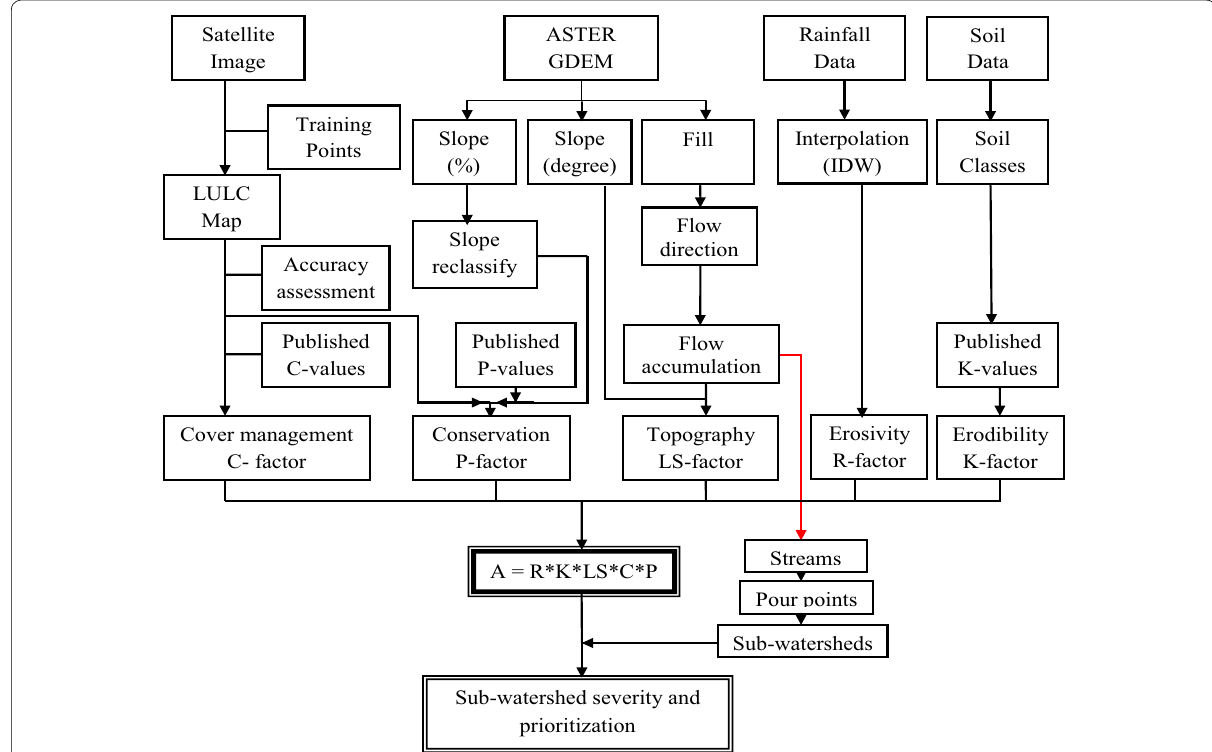
Fig. 4 Methodological flow of soil loss estimation using RUSLE model and watershed prioritization